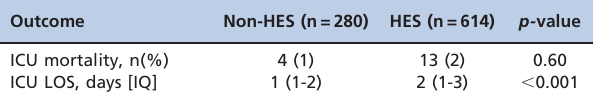
Additional Table 6 - Outcomes in the standard univariate